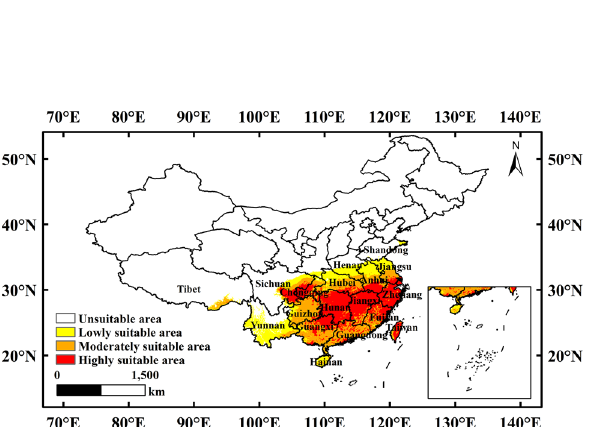
Figure 4. Potential suitable distribution of N. californicus in China based on MaxEnt under the current scenarios. Created in ESRI ArcMap 10.8.1 (https:// suppo rt. esri. com/ en/ Produ cts/ Deskt op/ arcgis- deskt op/